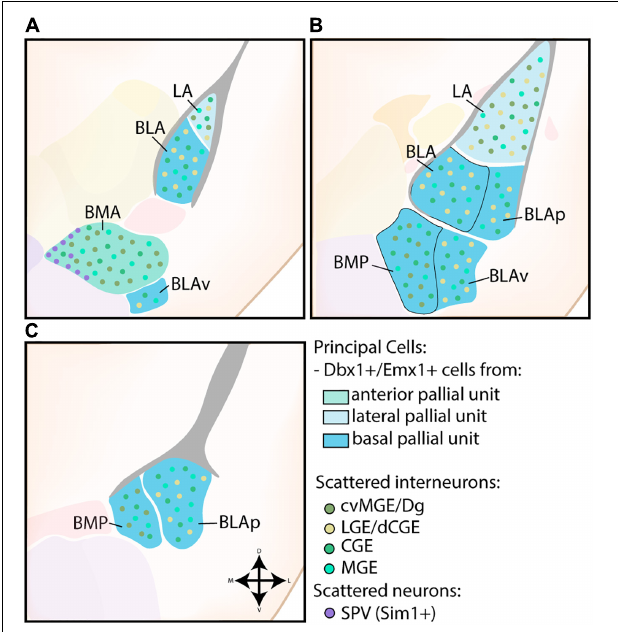
FIGURE 3 | Developmental origin of the basolateral complex. (A) The principal cells of the more anterior lateral amygdala (LA) and basolateral amygdala (BLA) are Dbx1-expressing neurons originating in the lateral and basal pallial units The anterior basomedial amygdala (BMA) contains a majority of Dbx1-expressing neurons from the anterior pallial unit, joined by Sim1-expressing neurons from the supraopto-paraventricular hypothalamus (SPV) at its medial side. In addition to these principal excitatory cells, some Emx1-expressing neurons are also present in the LA, BLA, and BMA at this level. The small part of the posterior ventral BLA (BLAv) contains a majority of excitatory Emx1-expressing cells from the basal pallial unit, with some Dbx1-expressing neurons scattered around (not shown). (B) The contributions from the Emx1-lineage increase along the rostrocaudal axis. At intermediate levels, more parts of the BLA become visible (BLAp and BLAv), both containing a majority of Emx1-expressing cells from the basal pallial unit, with some Dbx1-expressing cells still present (not shown). (C) At caudal levels, only the posterior subdivisions of the BM (BMP) and BLA (BLAp) are visible, both containing a majority of Emx1-expressing neurons with a minority of Dbx1-expressing neurons. Scattered interneurons can be found throughout the entire basolateral complex, with CGE and MGE-derived interneurons inhabiting the entire complex. In contrast, interneurons from the cvMGE/Dg area preferentially inhabit the LA and BM, while only data from the LA and BLA is available for dLGE/dCGE-derived interneurons from the